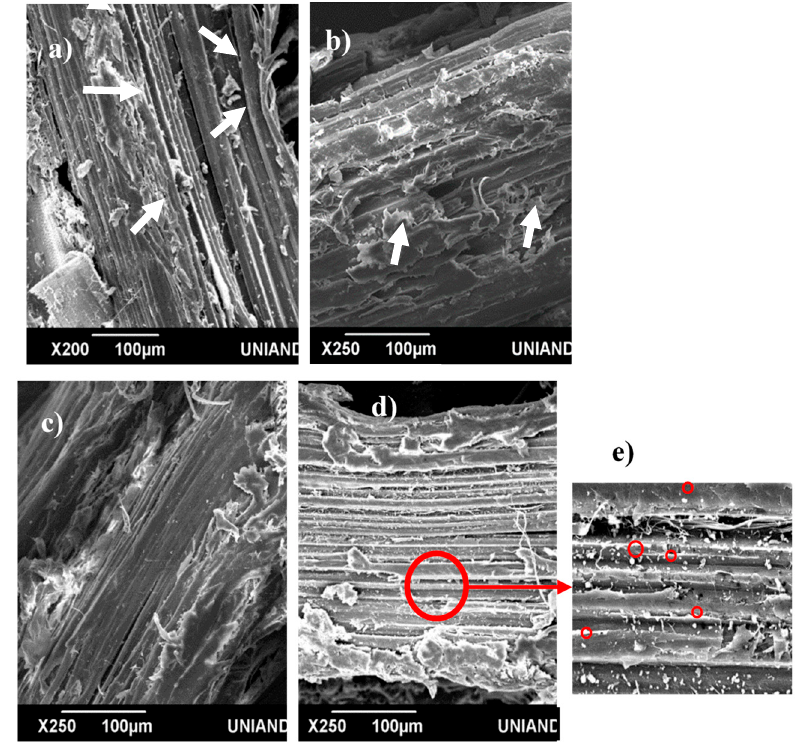
Figure 4. Scanning electron microscopy images of ( a ) untreated and ( b – e ) Ca(OH) 2 -treated G. angustifolia samples: ( b ) chips, ( c ) barkless, and ( d , e ) crushed (the circles in ( e ) indicates the calcium compounds on the surface).